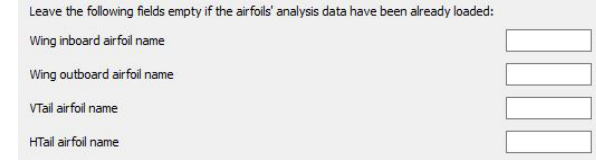
Figure 3: Aerodynamics Data Analysis fields.